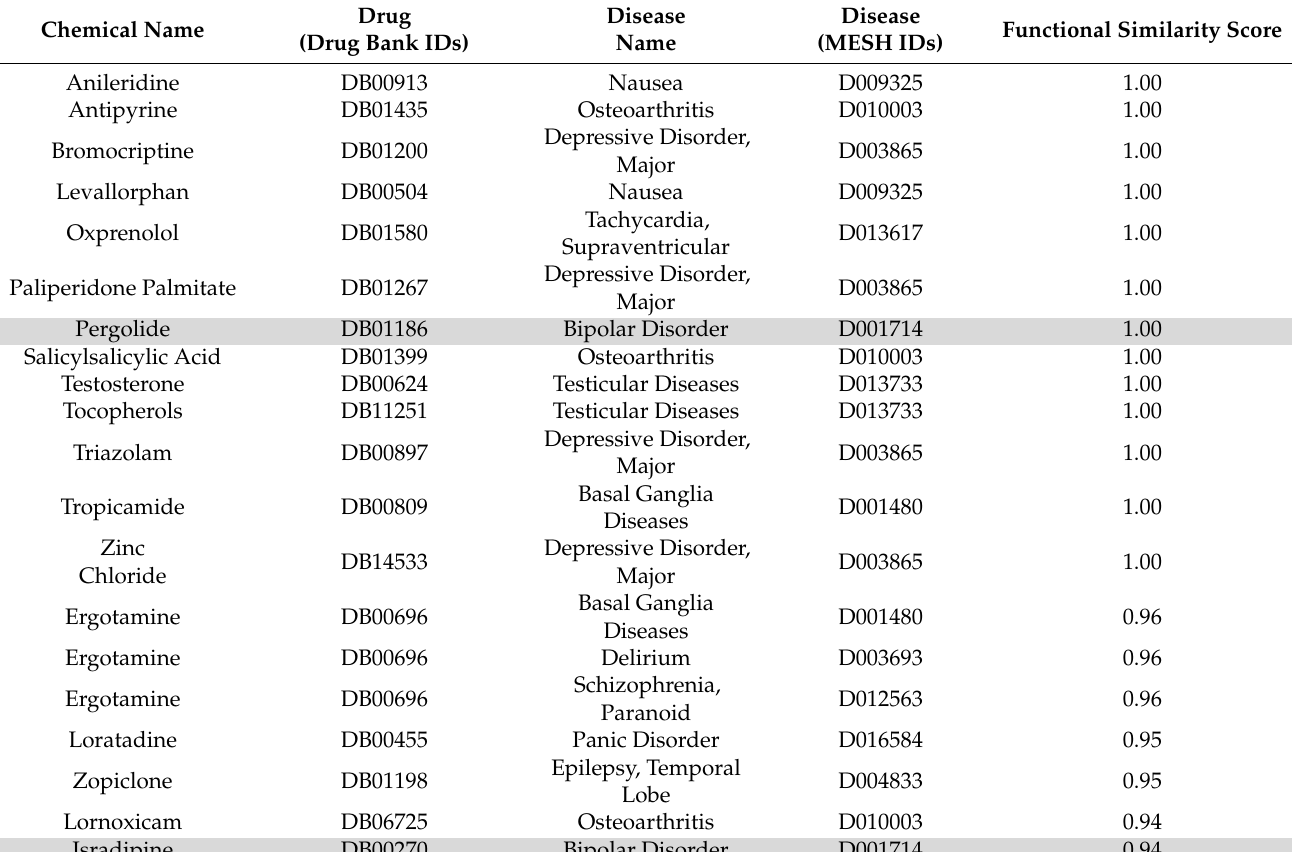
Table 7. The top 20 candidate drug–disease